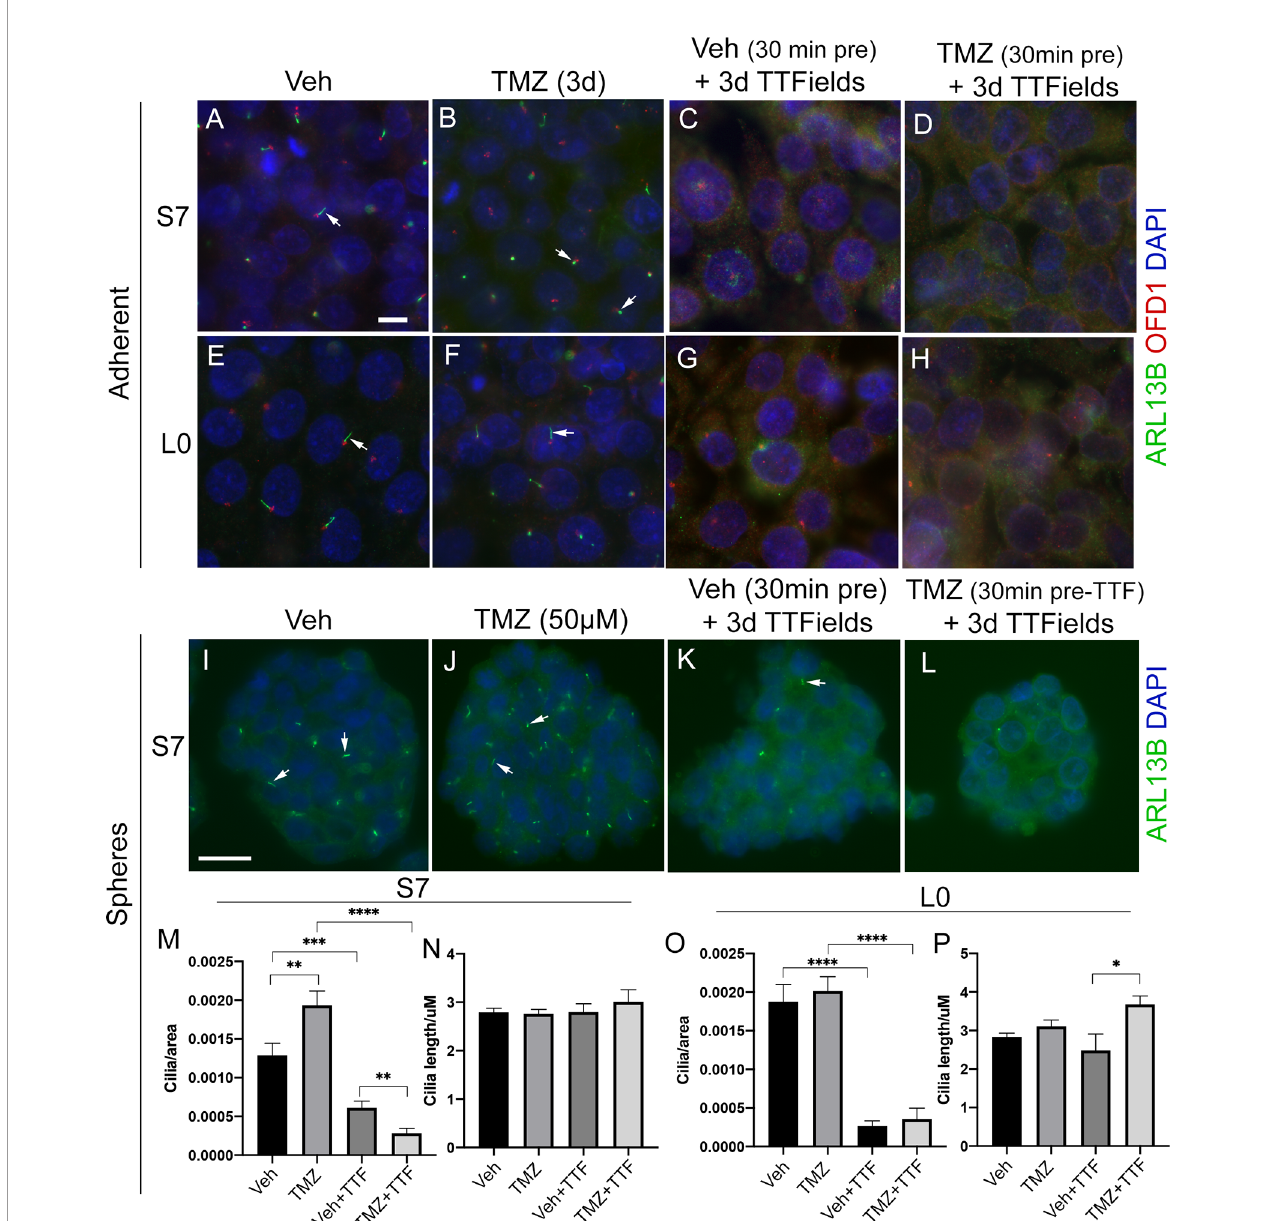
FIGURE 6 | TTFields blocks the TMZ-mediated increase in ciliogenesis. Adherent S7 cells pretreated with (A, C) vehicle or (B, D) 10 µM TMZ and left untreated (control) (A, B) or exposed to 3 days of TTFields (C, D) . Adherent L0 cells pretreated with (E, G) vehicle or (F, H) 20 µM TMZ and left untreated (control) (E, F) or exposed to 3 days of TTFields (G, H) . S7 and L0 cells were fi xed and stained for ARL13B (green) and OFD1 (red). Nuclei are labeled with DAPI (blue). Spheres of S7 cells pretreated with (I, K) vehicle or (J, L) 50 µM TMZ and left untreated (control) (I, J) or exposed to 3 days of TTFields (K, L) . To examine cilia, spheres were fi xed, sectioned, and stained for ARL13B (green, arrows). The number of cilia/per area (µm 2 ) of traced sections of (M) S7 or (O) L0 spheres for the indicated treatment. The mean length (µm) of cilia in (N) S7 or (P) L0 spheres for the indicated treatment. * p < 0.05; ** p < 0.01; *** p < 0.001; **** p < 0.0001 (ANOVA). Scale bars (in µm) in (A) = 10 and (I) =